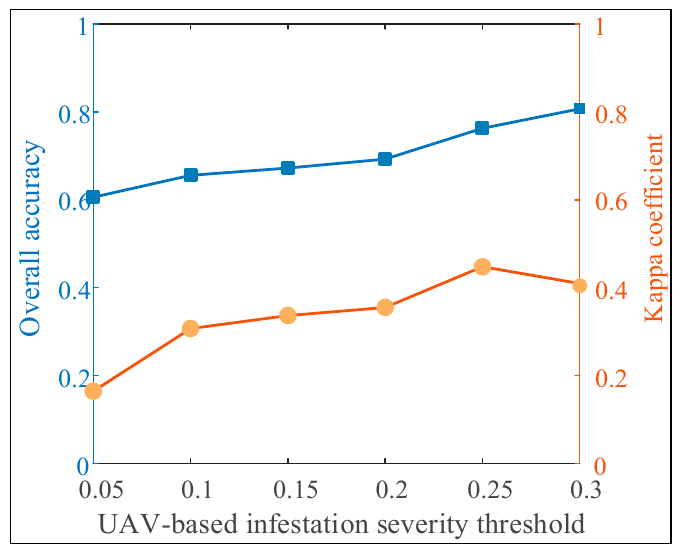
Figure 9. Validation of the predicted Sentinel-1 infestation map by the reference UAV-based infestation map obtained under different infestation severity thresholds.